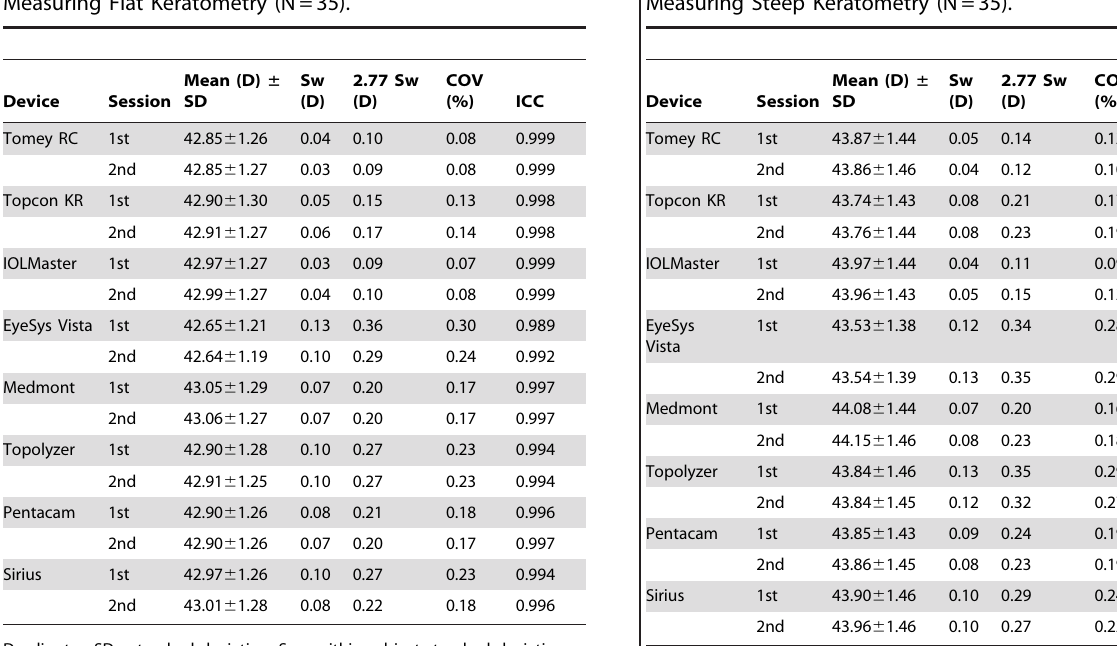
Table 2. Intrasession Repeatability of 8 Different Devices in Measuring Steep Keratometry (N =35).